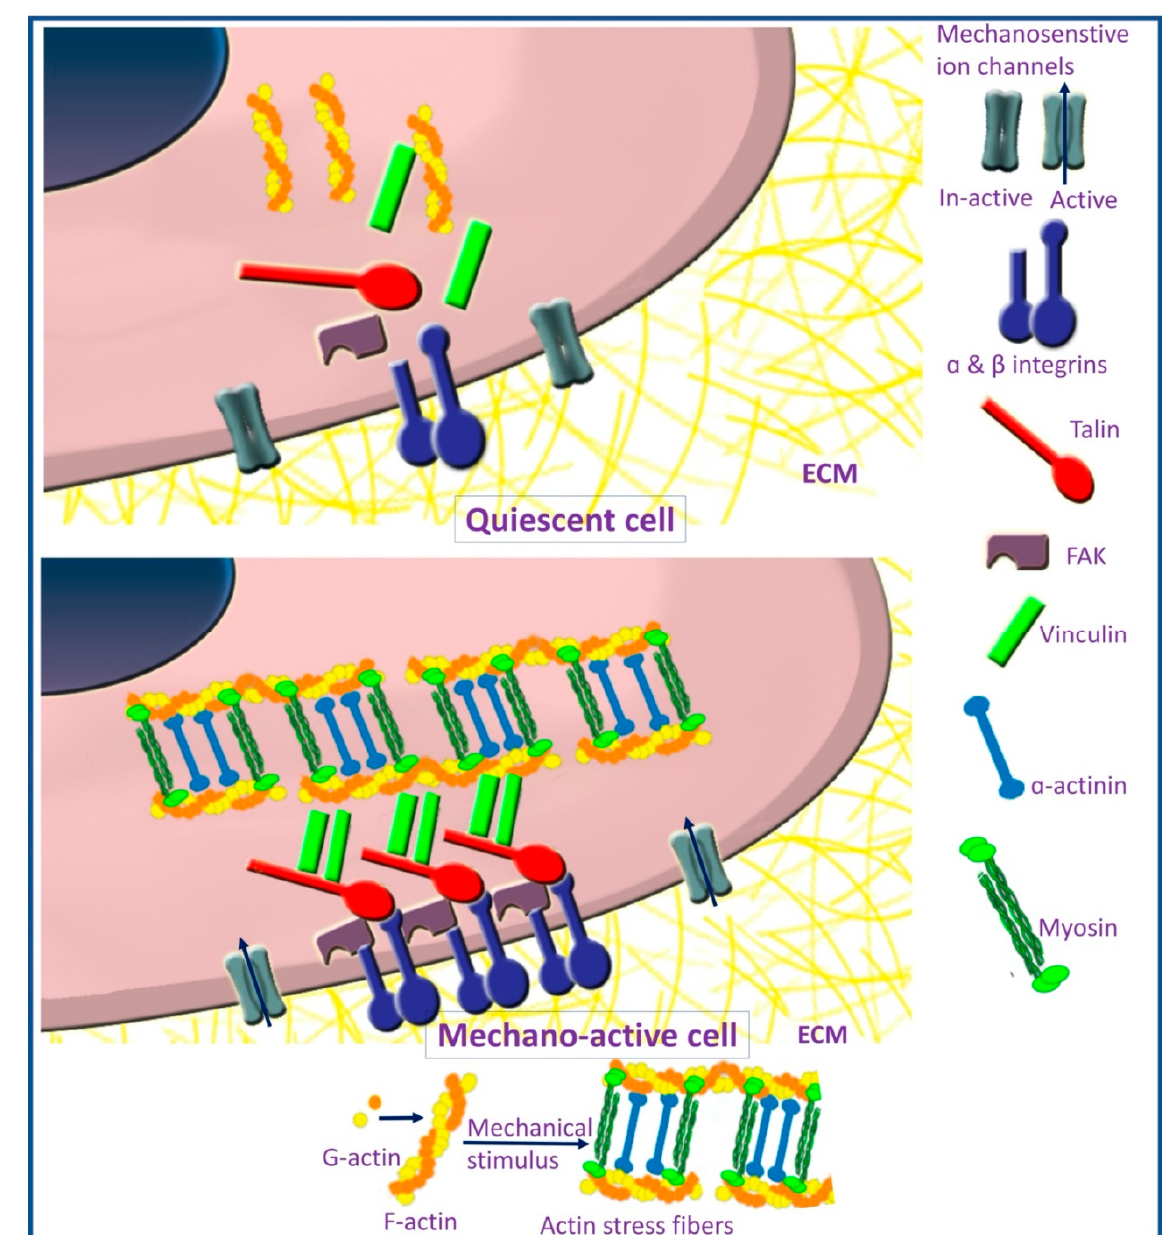
Figure 2. Focal adhesion formation and stress fibers assembly in mechano-active